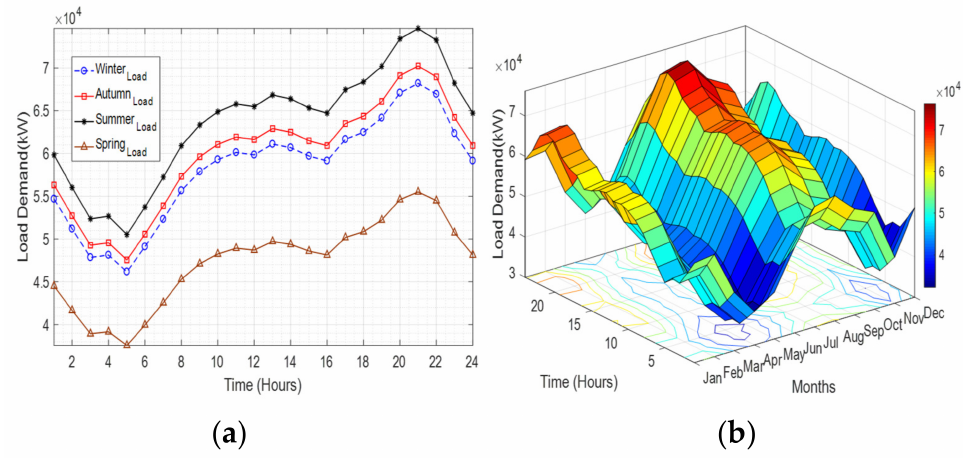
Figure 2. Load demand of the case study: ( a ) Seasonal and ( b ) Annual Counterplot.